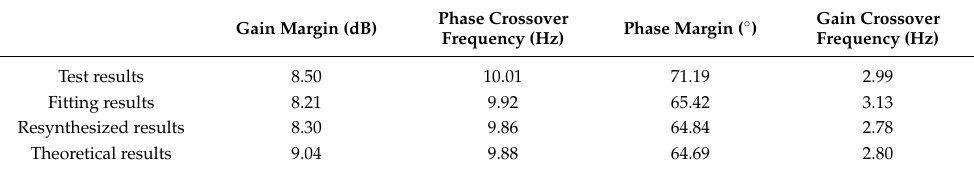
Figure 28. Comparison of open-loop FRF for the U1C1 state at Ma = 1.5. Table 4. Comparison of stability margins for the U1C1 state at Ma = 1.5.